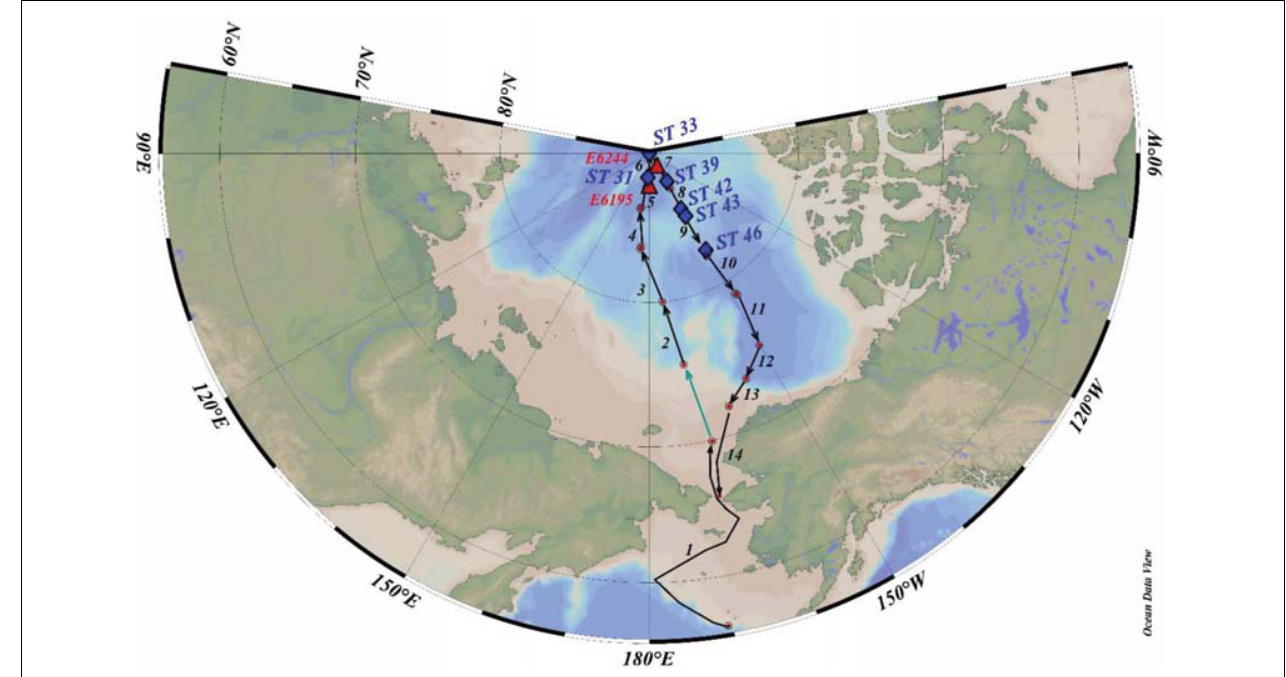
FIGURE 1 | Sampling stations for aerosols, ice-rafted sediment and ice stations. Green arrow shows transit with no sampling; distance between successive red dots denote aerosol sampling (starting and ending of location) for that particular sample; pumps didn’t work for ST-5 and no sample. Two red lettered stations (E6244 and E6195 in red triangle) denote the dirty sea ice sample collection; Blue lettered stations 31, 33, 39, 42, 43, and 46 denote ice stations (US GEOTRACES Arctic cruise, HLY1502, R/V Icebreaker USCGC Healy